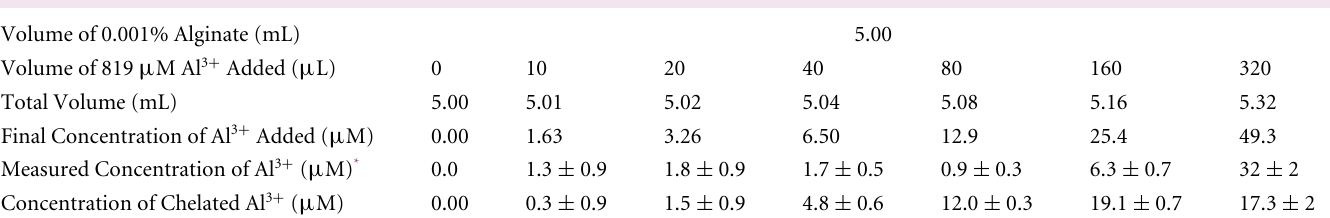
Table 1 Alginate chelation of Al 3 + ions parameters and